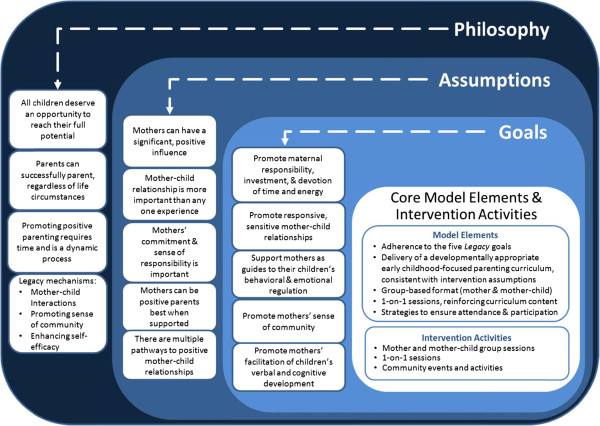
Legacy for ChildrenTMconceptual model.